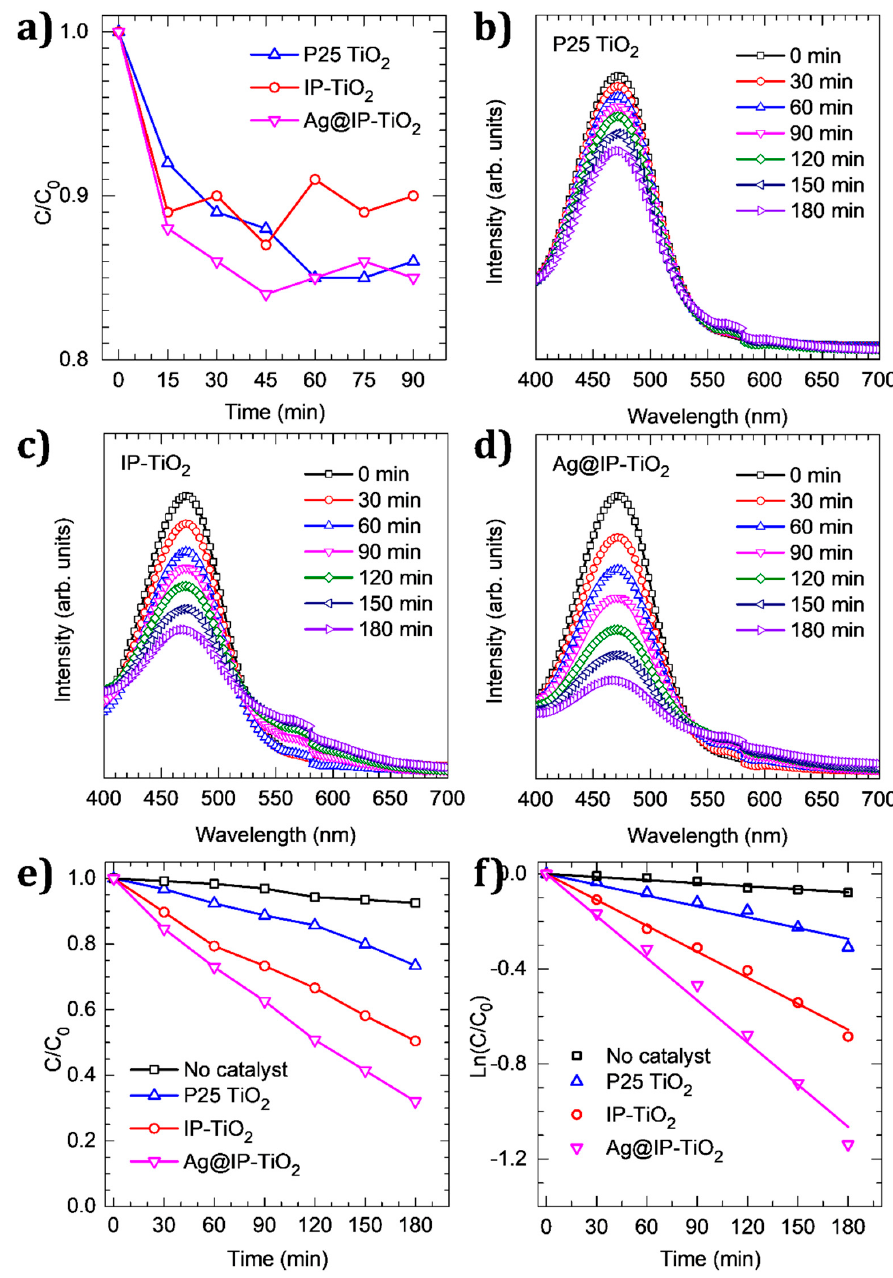
Figure 5. ( a ) adsorption of RIF on the catalyst surface before illumination; UV-VIS spectra of RIF solution as a function of irradiation time in the photocatalytic degradation caused by ( b ) P25 TiO 2 , ( c ) IP-TiO 2 , and ( d ) Ag@IP-TiO 2 ; ( e ) degradation curves of RIF as a function of exposure time and ( f ) the corresponding kinetic plots.